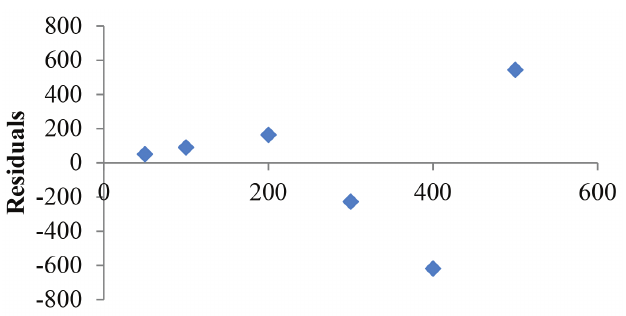
FIGURE 3 - Linearity Curve for venlafaxine HCl.